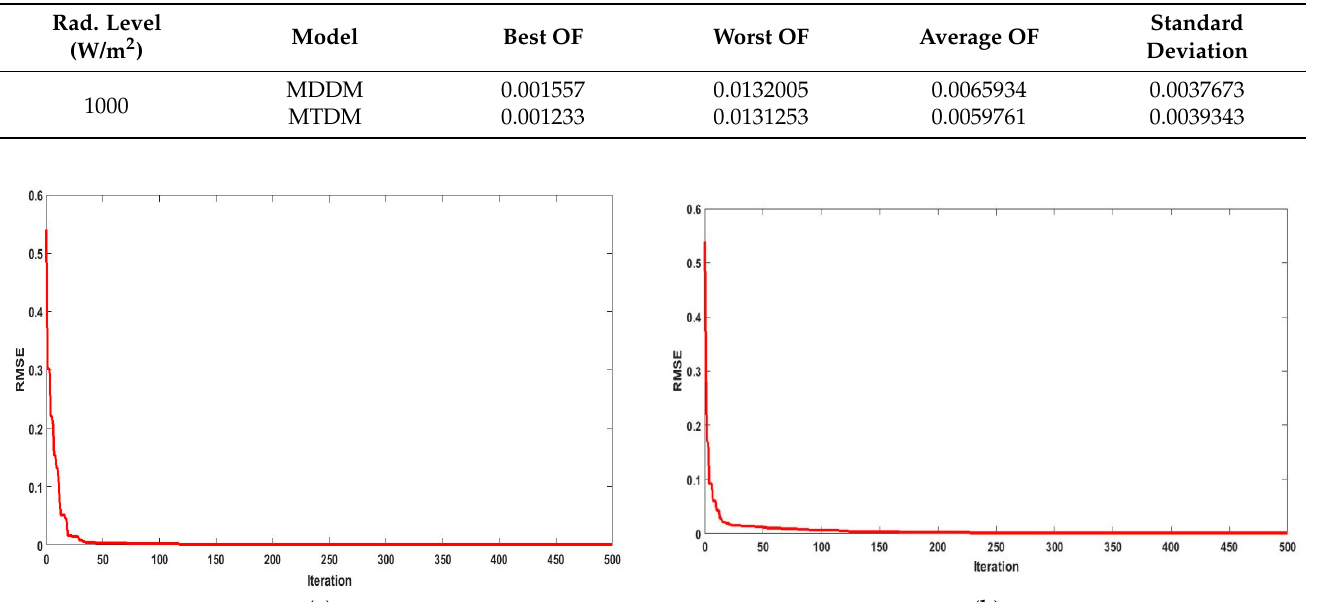
Table 6. The extracted parameters for MDDM and MTDM by EHO algorithms for 57 mm diameter commercial (R.T.C. France) silicon solar cell at 1000 W/m 2 and 306 K. Rad.